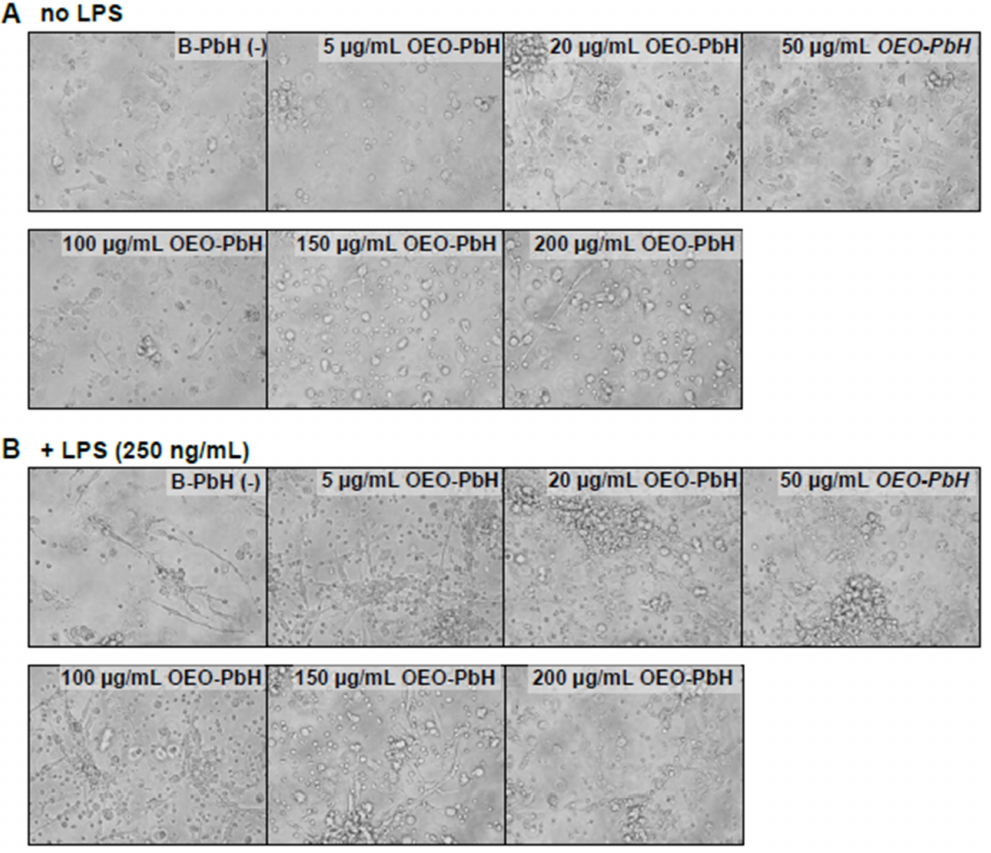
Figure 8. Brightfield microscopy images of OEO-PbH treated human DCs. DCs were cultured for 7 days with GM-CSF and IL-4. Cells were subsequently stimulated without LPS ( A ) or with LPS ( B ) and treated with either OEO-PbH or B-PbH formulations at different concentrations for 24 h. The images were taken under a light microscope using a 20 × objective.